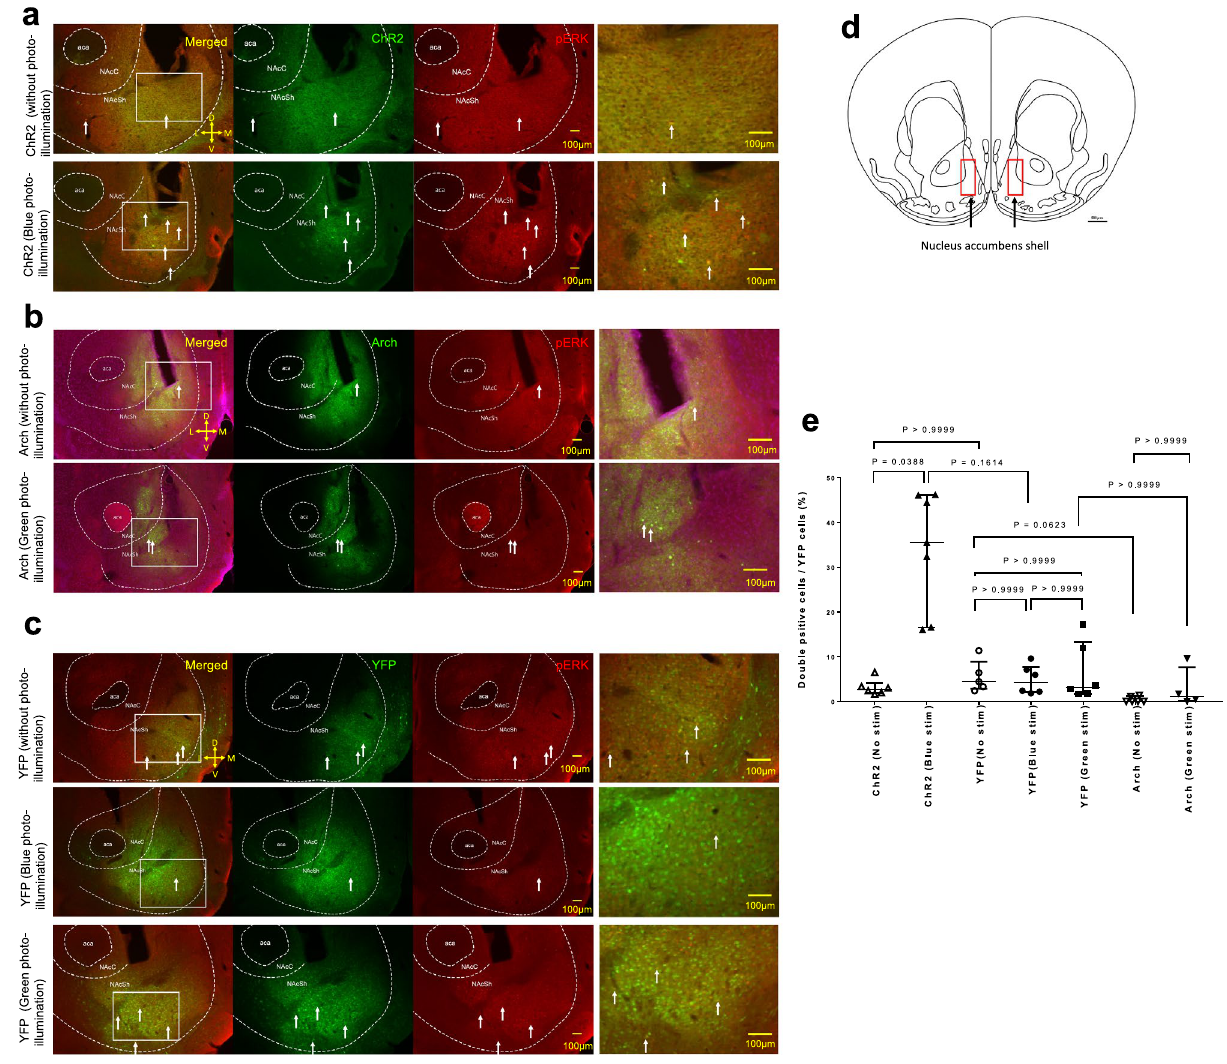
Figure 5. pERK immunostaining in the rostral NAc shell and percentage of double-positive cells in the rostral NAc shell. ( a – c ) Typical photographs from a brain of (from top to bottom); ChR2 mouse without photo illumination, ChR2 mouse with blue photo illumination, Arch mouse without photo illumination, Arch mouse with green photo illumination, YFP mouse without photo illumination, YFP mouse with blue photo illumination, and YFP mouse with green photo illumination. The left column is merged images and the middle left column is a green channel representing ChR2 (in a), Arch (in b), and YFP (in c). The middle right column is a red channel representing pERK and the rightmost channel is enlarged images shown in a white rectangle in the leftmost column. White arrows indicate double-positive cells in the NAc shell. Scale bar = 100 µm. Abbreviations: D, dorsal; V, ventral; M, medial; L, lateral; aca, anterior commissure; NAcC, nucleus accumbens core; NAcSh, nucleus accumbens shell. ( d ) Schematic diagram of the rostral NAc shell. The schematic diagram shows the location of the rostral NAc shell taken from the mouse brain atlas. The red rectangles were counted in the area (400 × 1000 μm) of AAV-YFP, AAV-ChR2, or AAV-Arch cells and pERK cells, including the rostral NAc shell. Scale bar = 500 µm. ( e ) The percentage of double-positive cells (pERK-positive and YFP-positive cells / YFP-positive cells) in the rostral NAc shell. Kruskal–Wallis test showed a significant difference among the groups (P = 0.0001, ChR2 (No stim) n = 6, ChR2 (Blue stim) n = 7, YFP (No stim) n = 5, YFP (Blue stim) n = 6, YFP (Green stim) n = 6, Arch (No stim) n = 6, Arch (Green stim) n = 4). A post hoc test revealed a significant difference between ChR2 (No stim) and ChR2 (Blue stim). P values from Dunn’s test were indicated in the figure. Horizontal bars represent the median with the interquartile